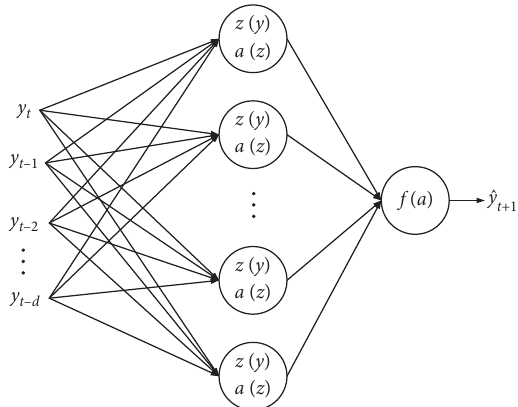
Figure 1: Topology of the Narnet model.